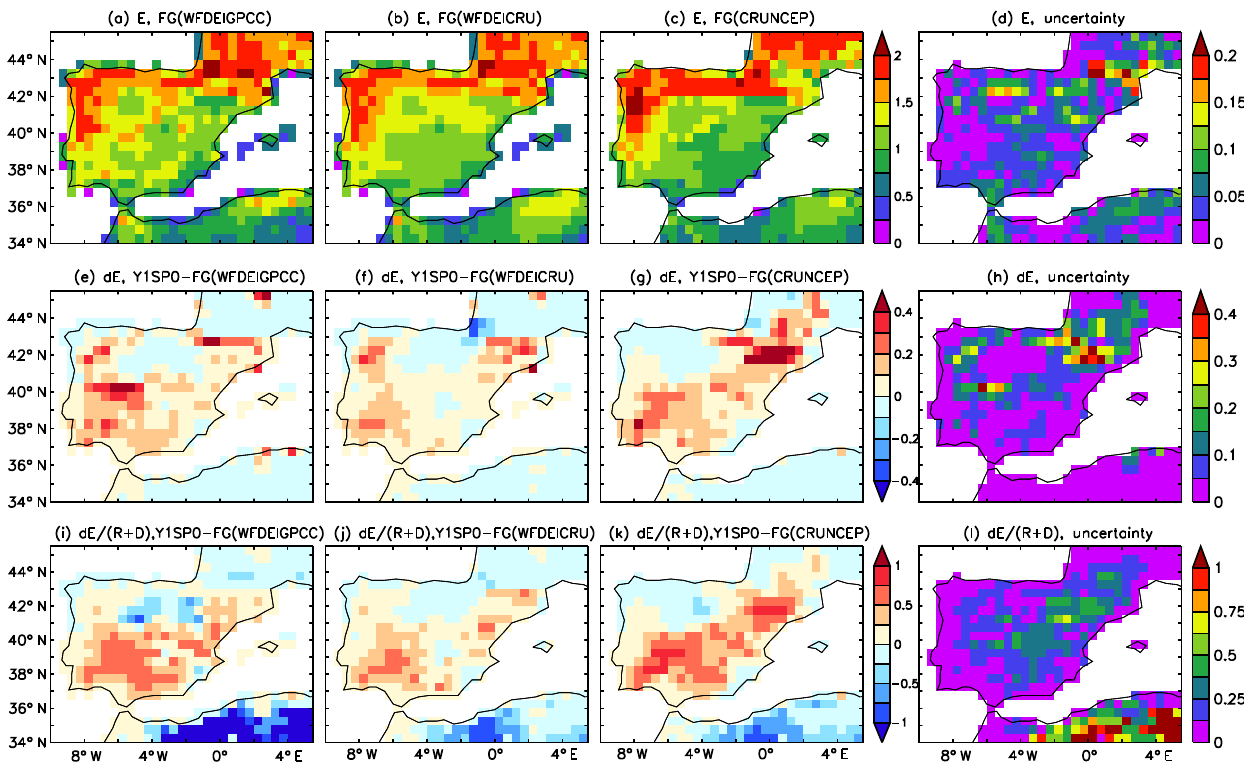
Figure 9. The evaporation ( E , in mmday − 1 ) before assimilation (1st row), change of evaporation (dE, in mmday − 1 ) after and before assim- ilation (2nd row) and the ratio of dE and runoff + drainage (3rd row) for forcing WFDEI-GPCC (1st column), WFDEI-CRU (2nd column), CRU-NCEP (3rd column) and the “Uncertainty” (defined by Eq. 10) in different forcing (4th column) averaged from 1980 to